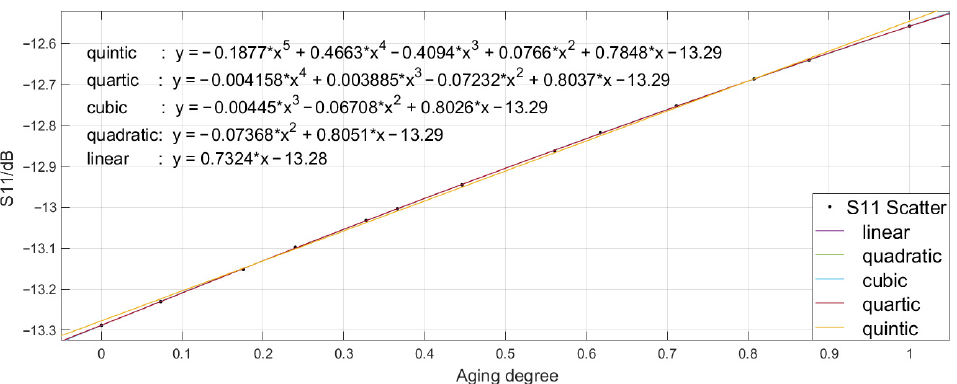
Figure 10. Fitting curve diagram of the relationship between the aging degree of silicone rubber and the terahertz S11 parameter.